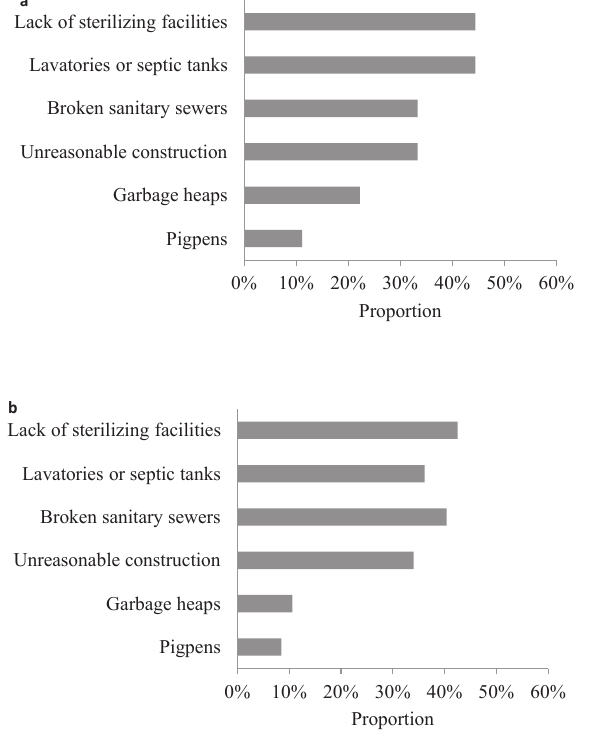
Fig. 3. Proportions of sanitary conditions of wells and its surroundings in a) urban areas and b) rural areas.